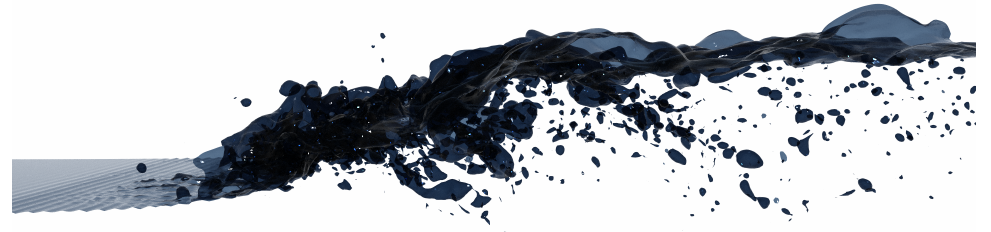
Figure 1. Classical hydraulic jump at Fr 1 = 2; a snapshot of the air–water